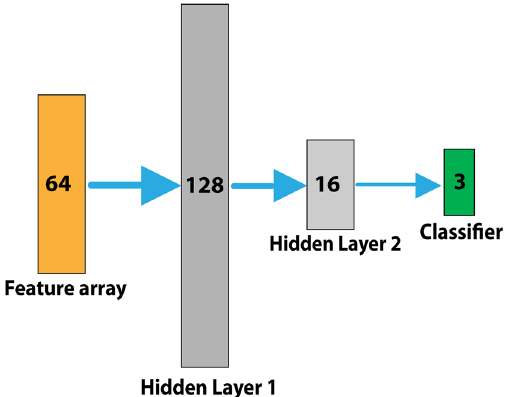
Figure 2. Neural network classifier including two hidden layers of 128 and 16 neurons respectively, followed by a final classifier to classify cases into three categories of normal, COVID-19, non-COVID-19 pneumonia.